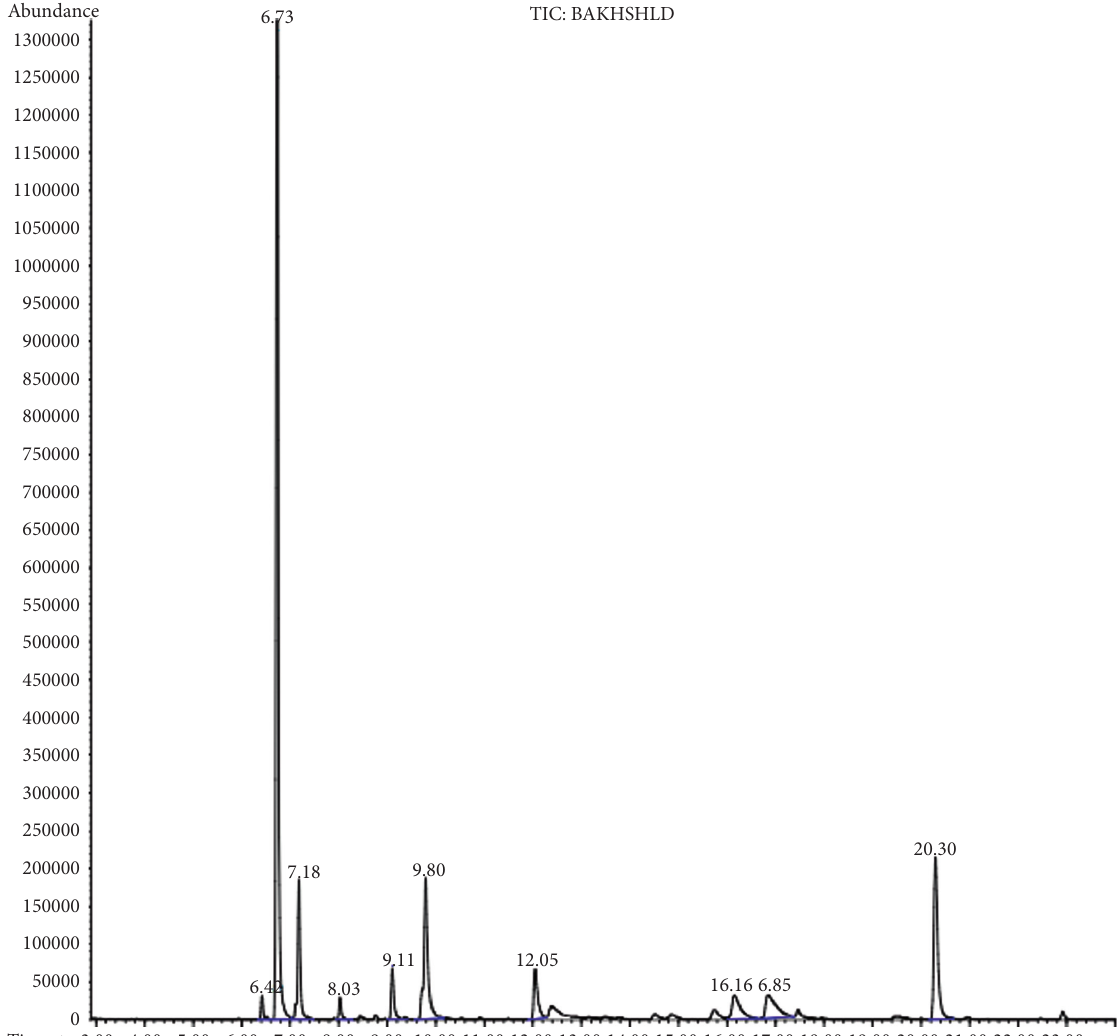
Figure 11: GC-MS analysis of p. vera methanolic